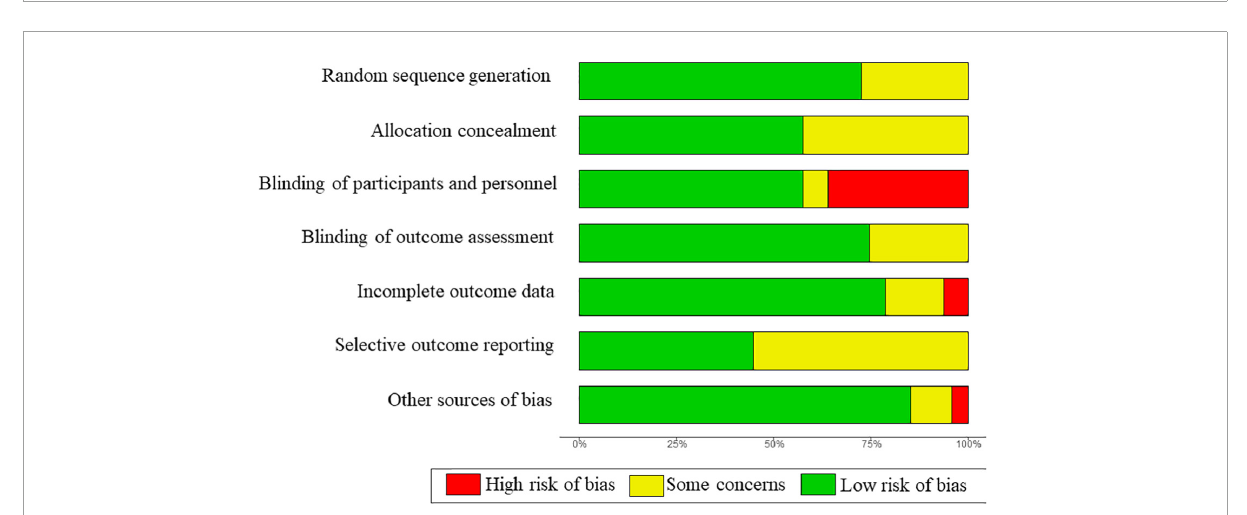
FIGURE2 Summary of risk of bias across all included